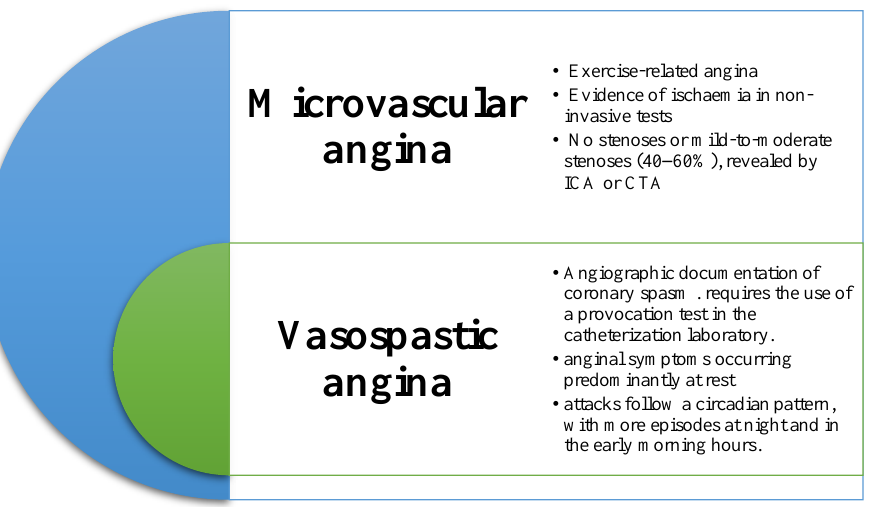
Figure 1. Angina without obstructive disease in the epicardial coronary